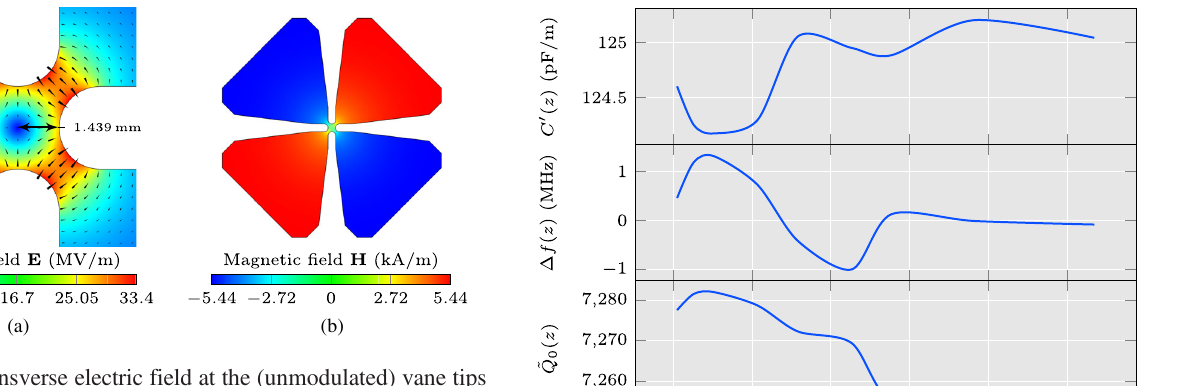
FIG. 2. Transverse electric field at the (unmodulated) vane tips (a) and longitudinal magnetic field in the RFQ cavities (b).